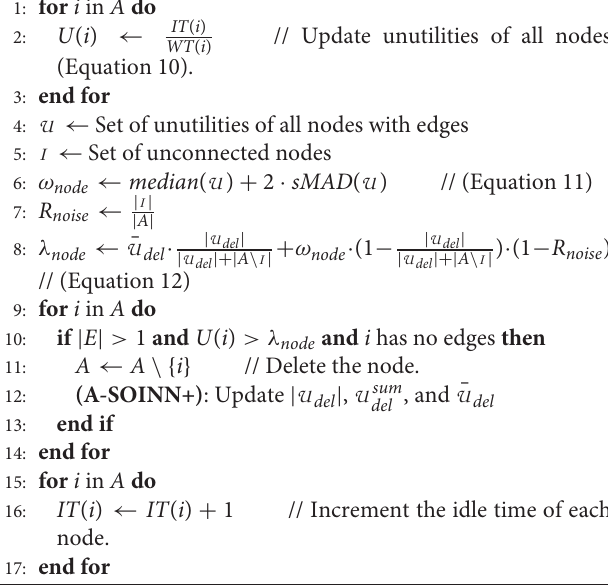
Algorithm 6 . (Associative) SOINN+ Node